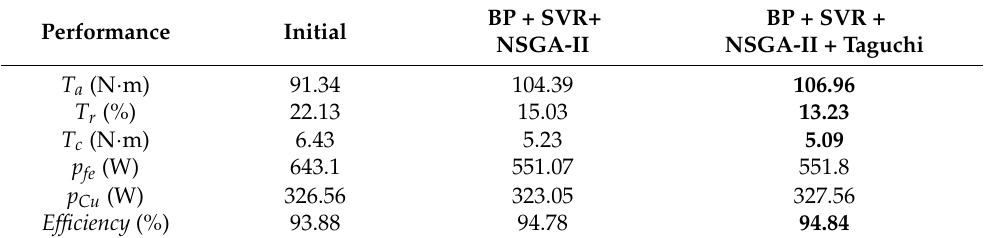
Figure 9. Performance comparison of the initial motor and the optimized motor: ( a ) comparison of T a ; ( b ) comparison of p fe ; ( c ) comparison of p Cu . T a ; ( b ) comparison of p fe ; ( c ) comparison of p Cu . Table 10. Performance comparison of initial motor and optimized motor with different optimization Table 10. methods.